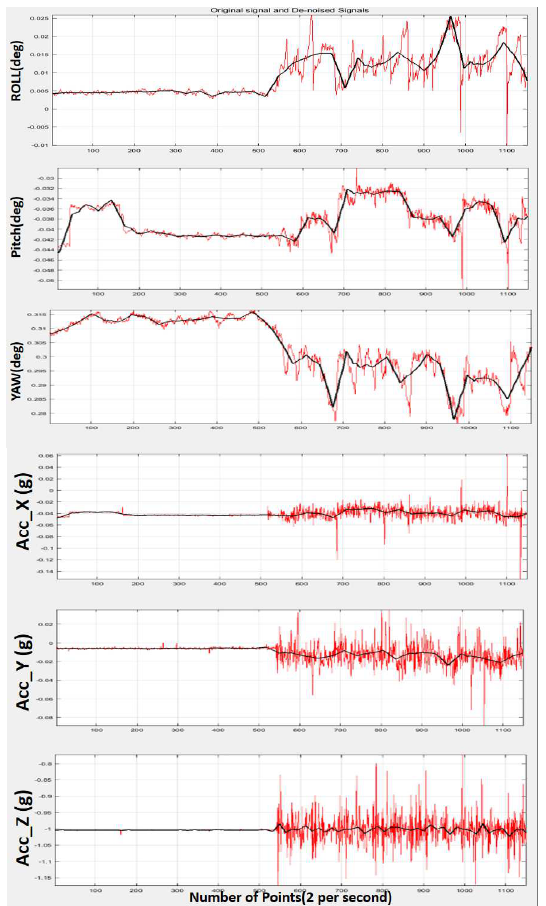
Figure 8. Euler angler and Acceleration graphs with rotors on and off with static position